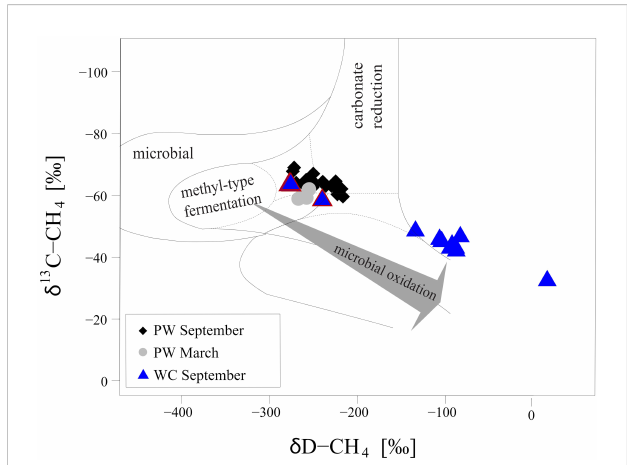
FIGURE 6 Classi fi cation of the sources of CH 4 based on the CH 4 isotopic composition ( d 13 C-CH 4 and d D-CH 4 ) modi fi ed after (Whiticar, 1999; Egger et al., 2017). Grey circles indicate data for the porewater from March 2020. Black diamonds represent samples from the porewater in September 2020. Blue triangles show the isotopic composition of the water column samples in September 2020. The triangles outlined in red indicate samples taken below the oxycline (including the sample at the oxycline, from 35m). The grey arrow indicates the direction of the shift in isotopic composition due to microbial CH 4 oxidation (Whiticar,